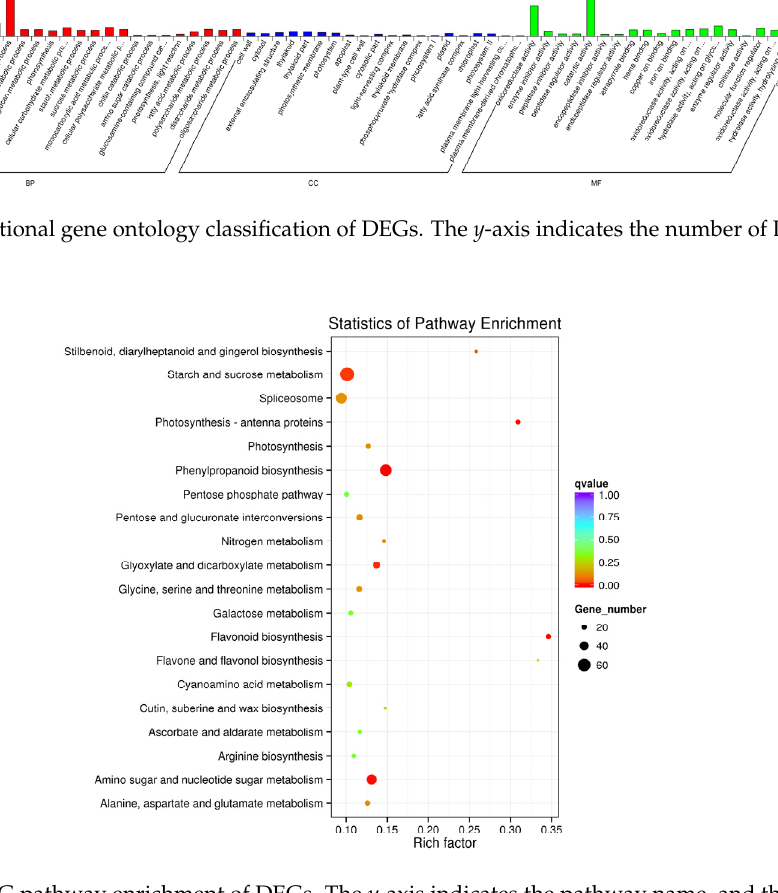
Figure 6. KEGG pathway enrichment of DEGs. The y ‐ axis indicates the pathway name, and the x ‐ axis indicates the enrichment factor corresponding to the pathway. The q ‐ value is represented by the color of the dot. The number of DEGs is represented by the size of the dots.